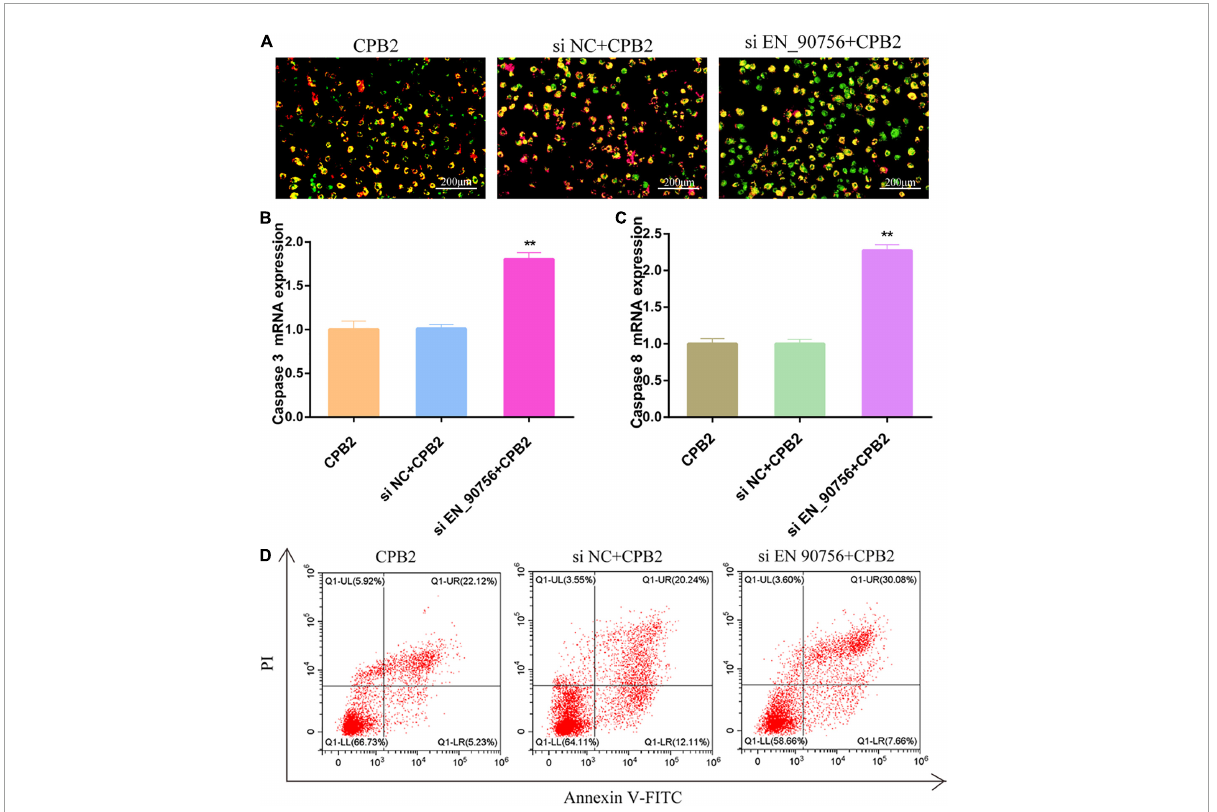
FIGURE5 Knockdown of long non-coding RNA (lncRNA) EN-90756 promoted apoptosis in intestinal porcine epithelial cell line-J2 (IPEC-J2) cells. (A) The (cid:49) ψ m was detected in IPEC-J2 cells treated with Clostridium perfringens beta2 (CPB2) for 24 h and stained using the JC-1 probe. Scale bar = 200 µ m. The shift from red to green fluorescence represents a decrease in cell membrane potential. The mRNA expression of caspase 3 (B) and caspase 8 (C) in cells treated with 20 µ g/ml CPB2 toxin for 24 h. (D) Apoptosis was detected using Annexin V-fluorescein isothiocyanate. ** p <